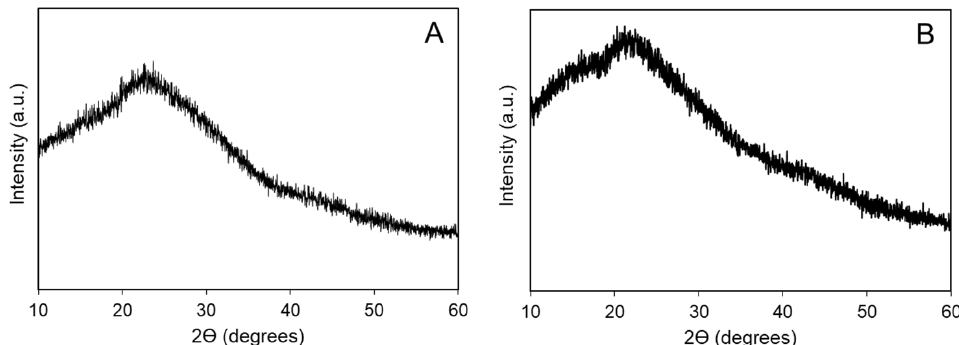
Figure 2. Diffractograms of A. macleodii Mo 169 EPS ( A ) and its EPS/SeNPs bio-nanocomposite ( B ).